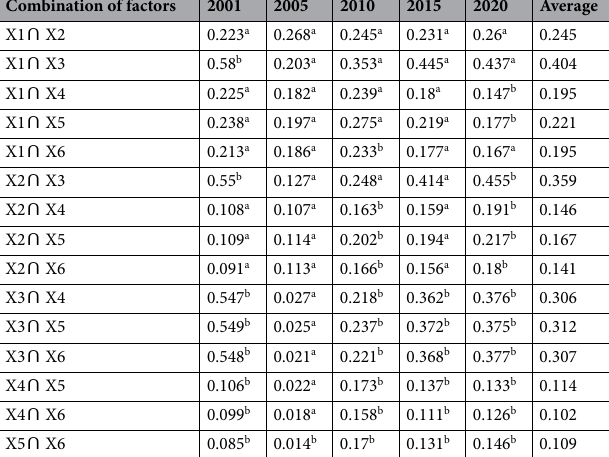
Table 8. Results of interactive detection. a Non-linear enhancement relationship. b Two-factor enhancement